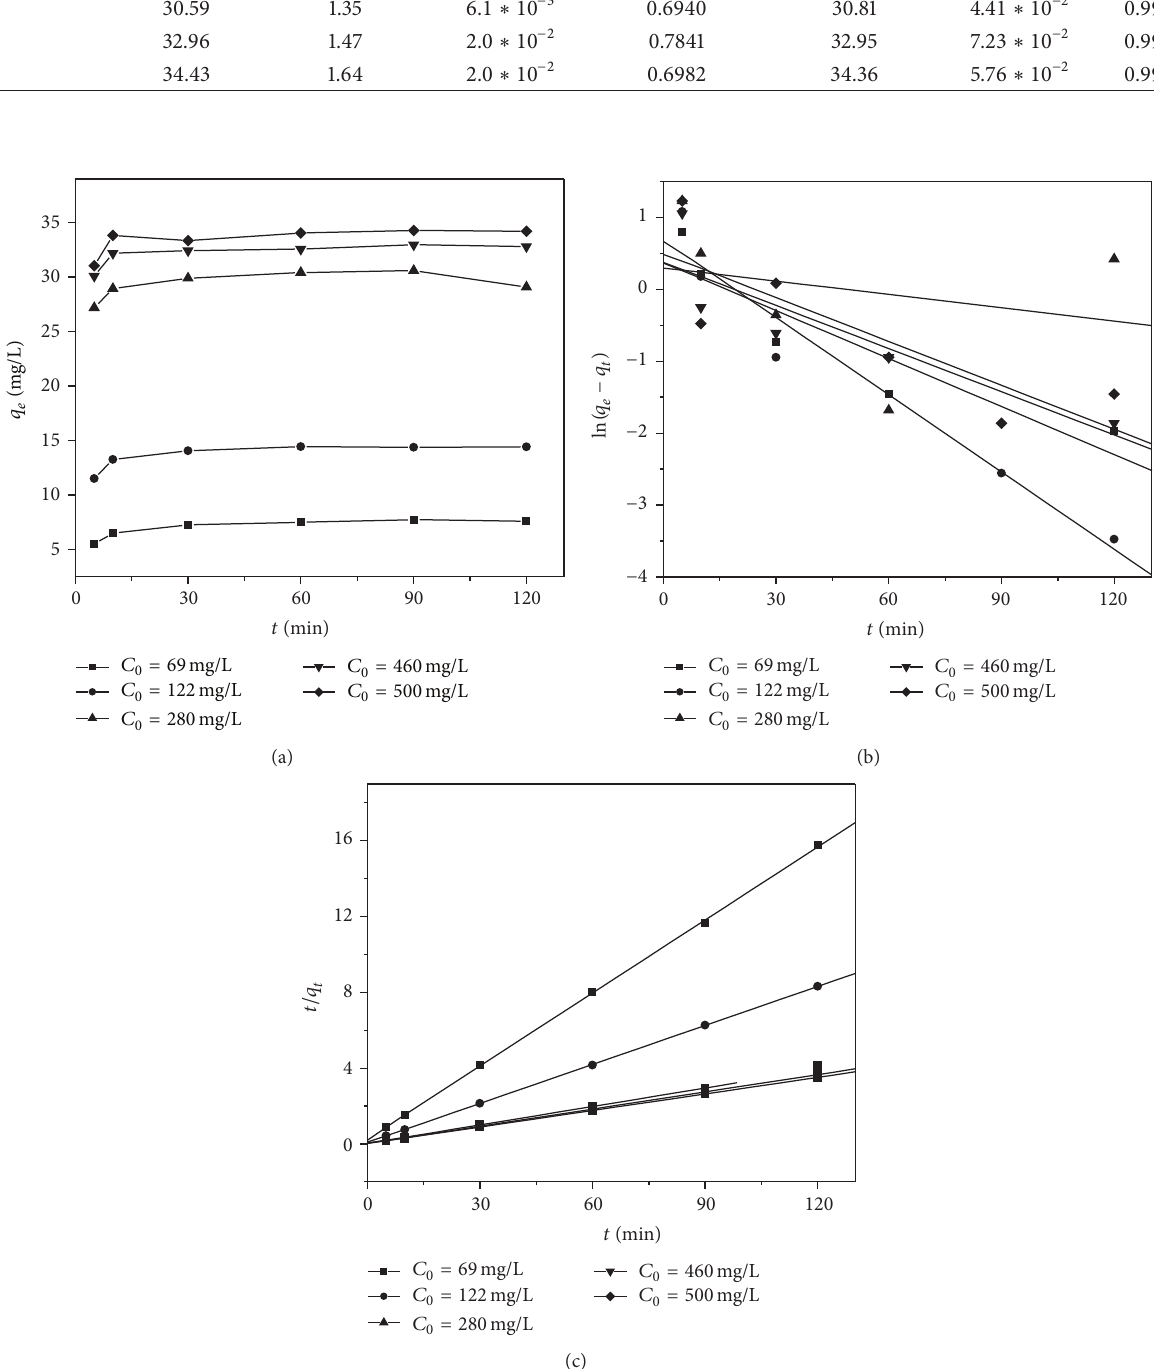
Figure 7: Adsorption kinetics of ammonium from aqueous solution: (a) effect of contact time on ammonium adsorption, (b) pseudofirst- order kinetic model, and (c) pseudosecond-order kinetic